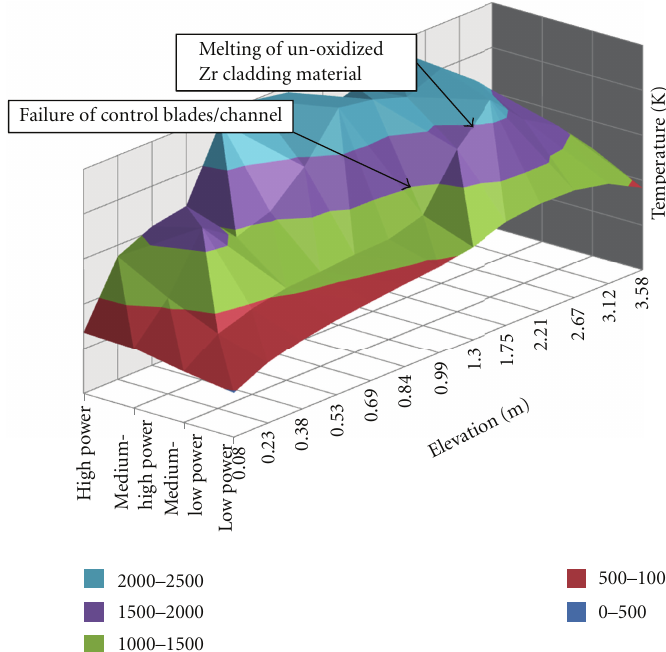
Figure 31: Core temperature at 41.7 hours for a scenario with depressurization (all emergency water injection was terminated at 40 hours after reactor